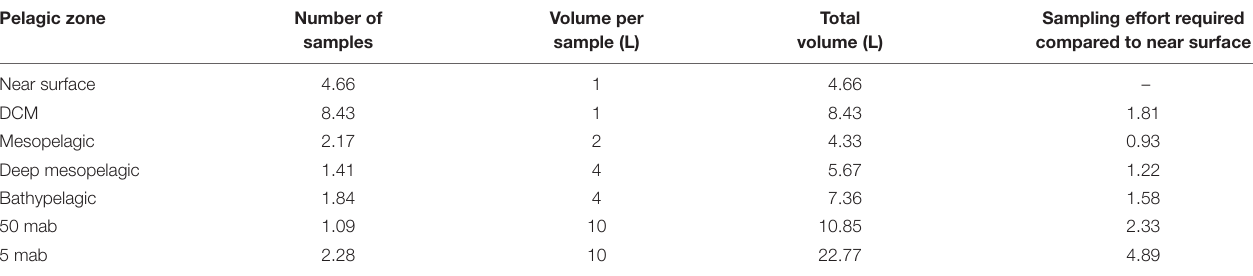
Pelagic zone Number of